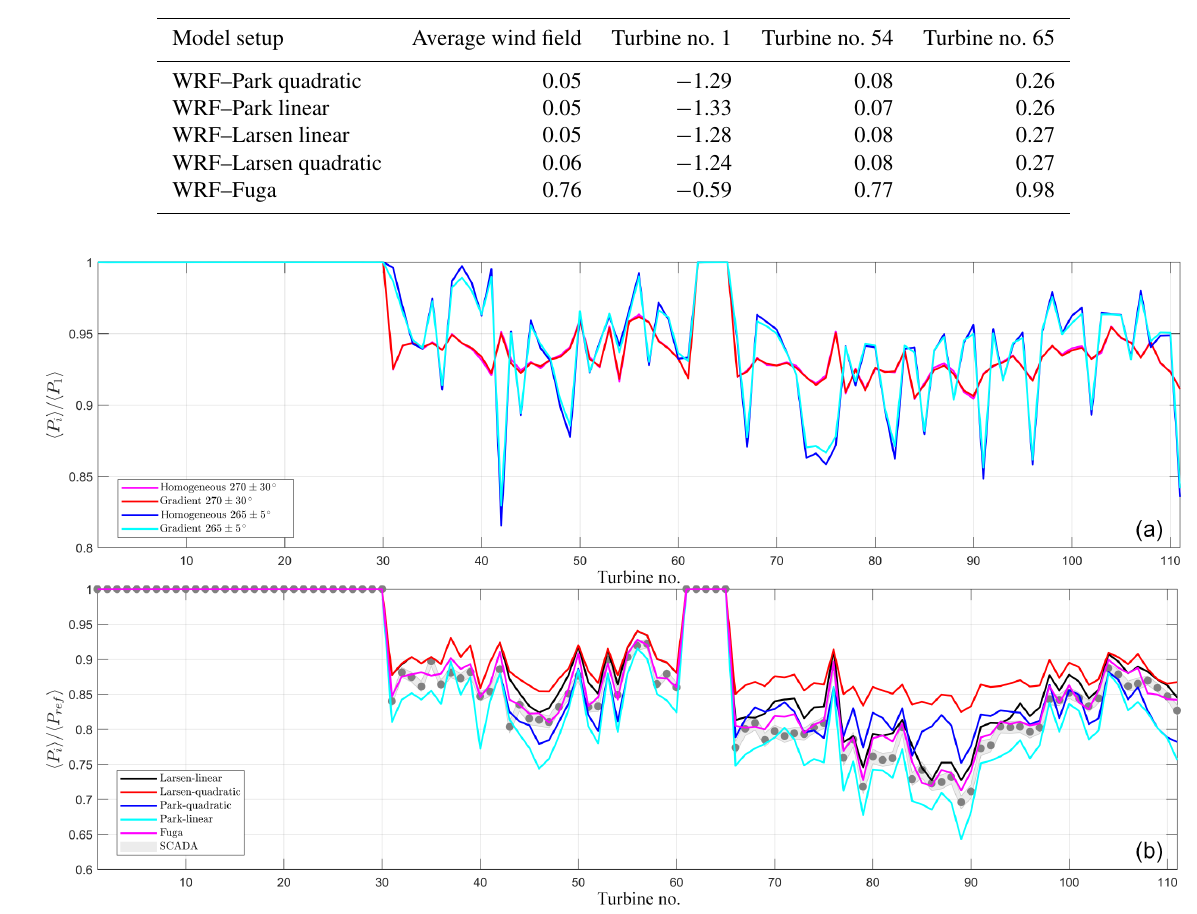
Figure 6. Normalized average power of each turbine in the wind farm for westerly flow conditions. (a) From simulations using the 2014 WRF time series and Park quadratic with (gradient) and without (homogeneous) the horizontal wind-speed gradient information. (b) From SCADA and simulations from the wake models within the range 270 ± 30 ◦ and hub-height inflow wind speed of 5–10ms − 1 . For the SCADA, the shaded region indicates ± the standard error of the